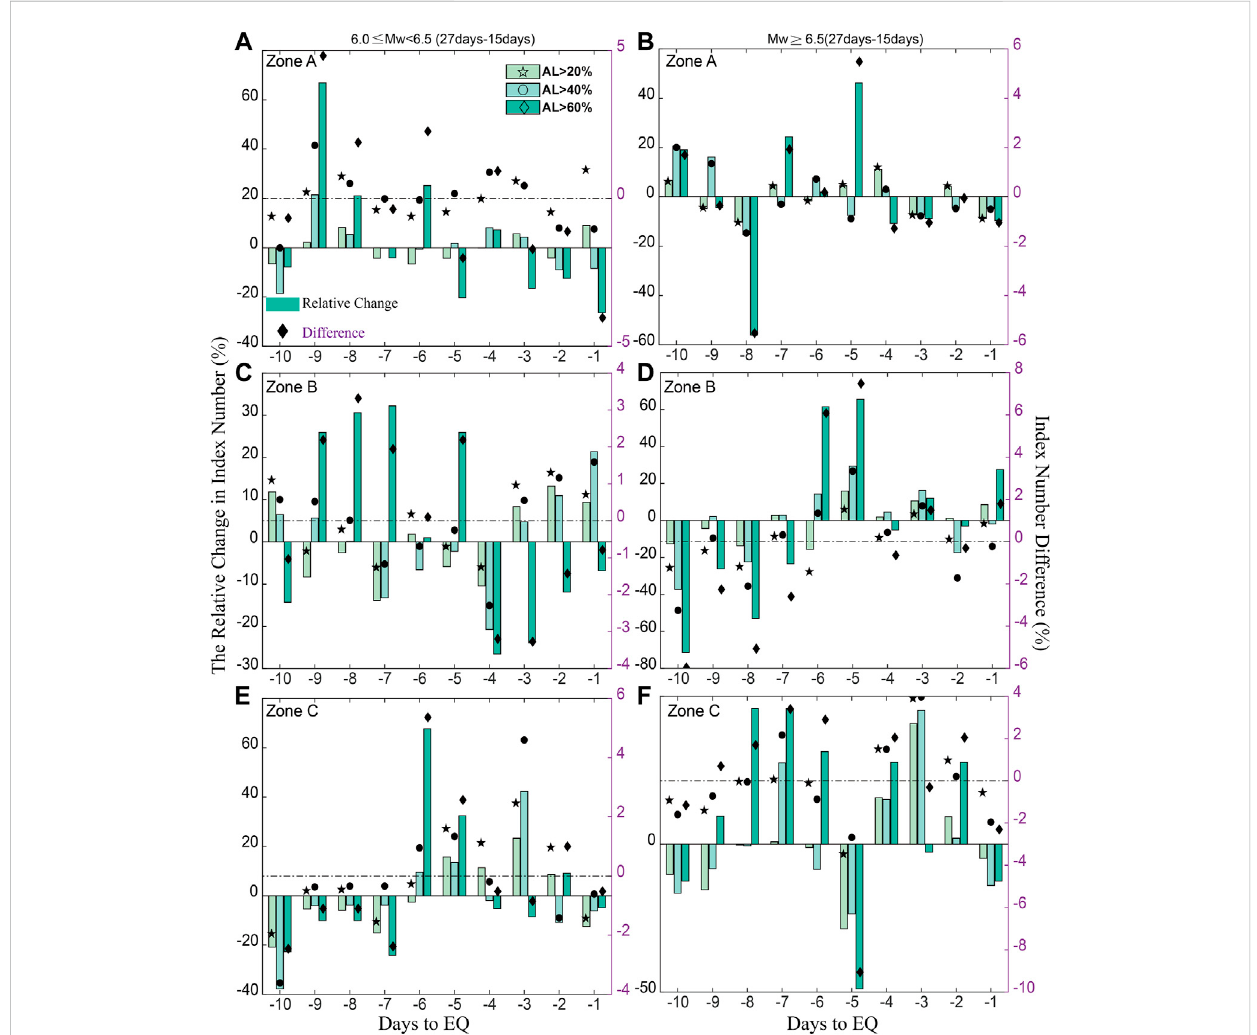
FIGURE 6 The differences and relative changes of the Index Numbers of the seismo-ionospheric anomalies between the results of 27-day and 15-day sliding windows. (A, C, E) represent the results of 6.0 ≤ Mw < 6.5 in Zone A, Zone B and Zone C, respectively. (B, D, F) represent the results of Mw ≥ 6.5 in Zone A, Zone B and Zone C,